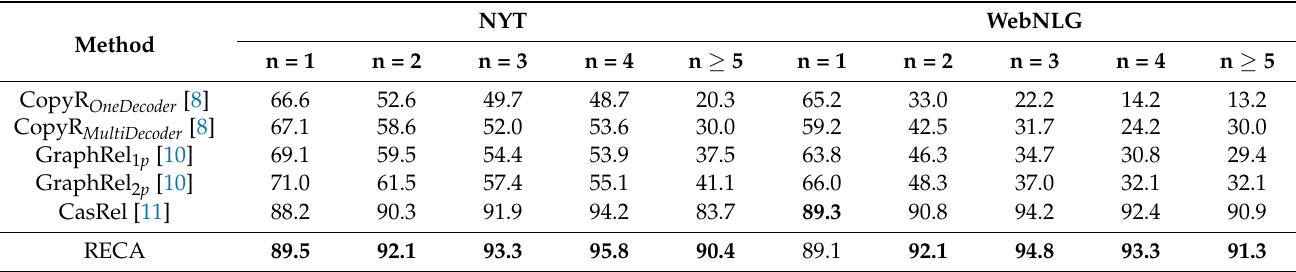
Table 4. F1-scores for the extraction of relational triplets from sentences with different numbers of triplets. The best scores are in bold